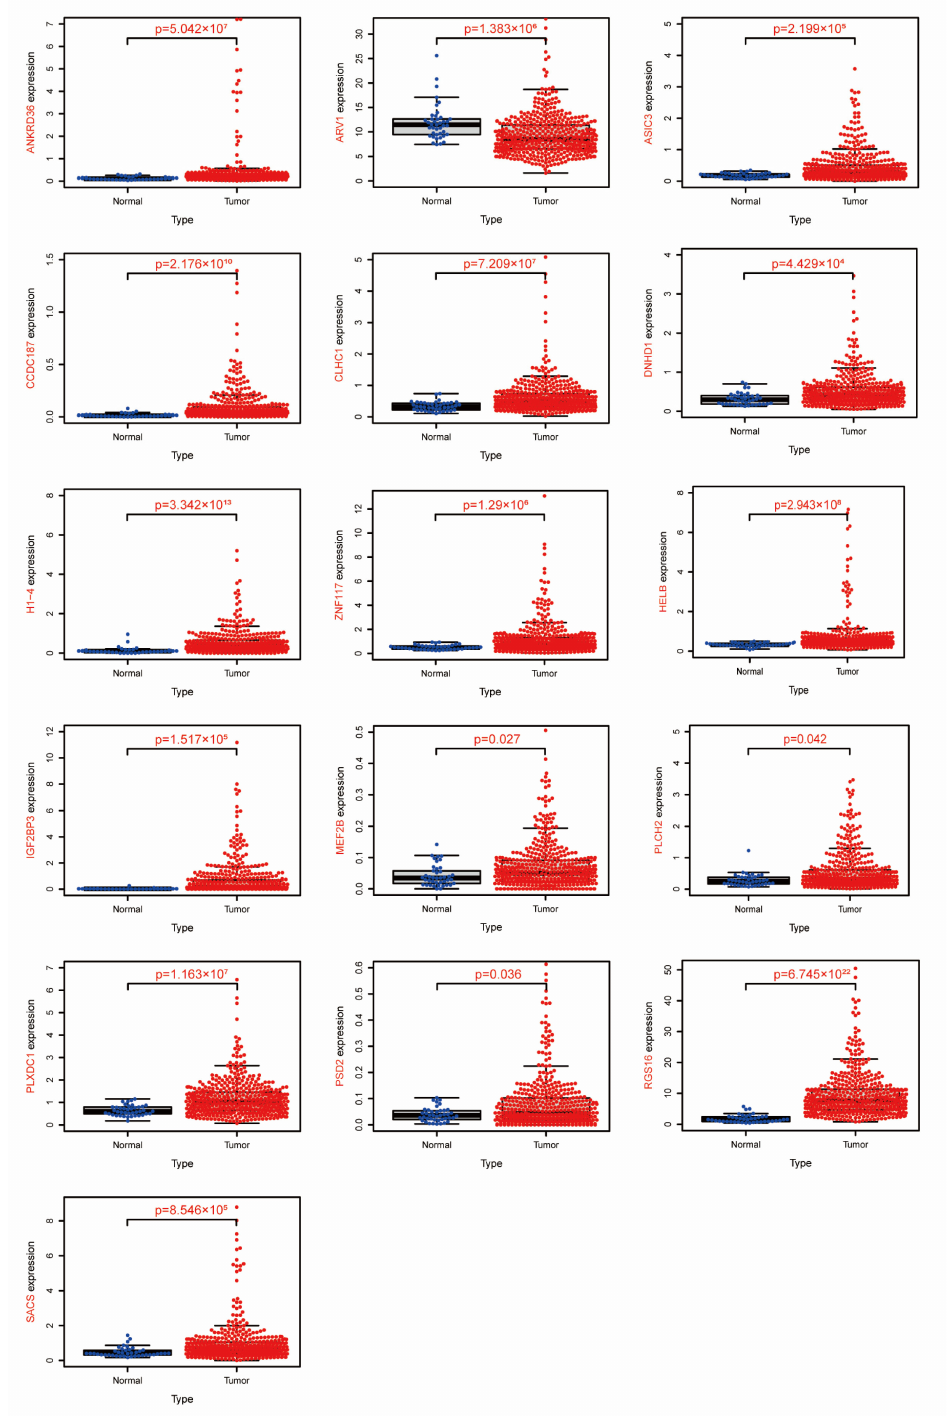
Figure 4. Expression of 16 DEGs in tumor tissues and normal tissues based on the TCGA-COAD cohort. Blue dots represent normal tissue and red represent colorectal cancer